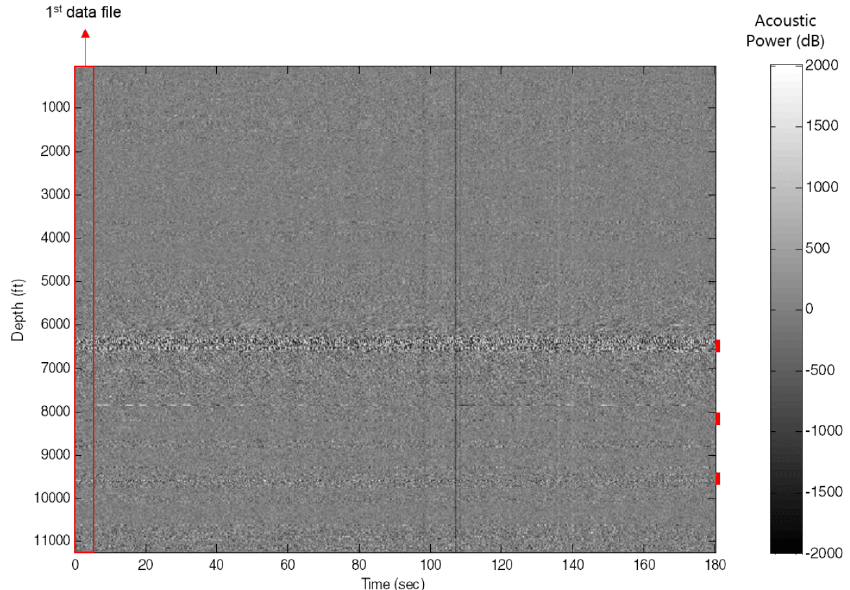
Figure 5. Raw acoustic data collected from a multilateral well. Reprinted from ref. [34].